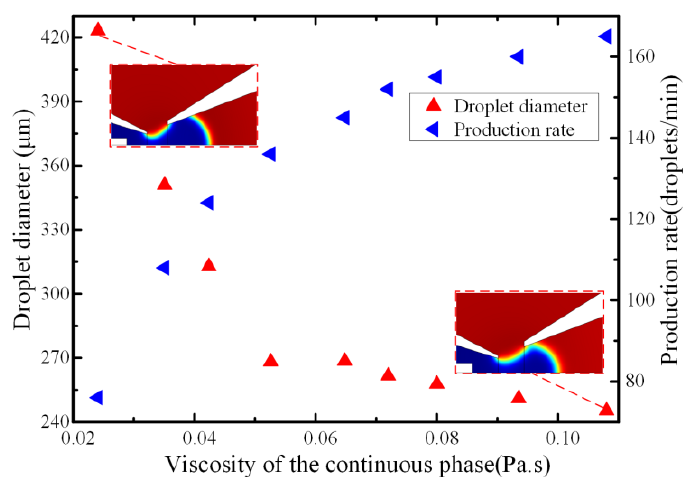
Figure7. Thee ff ectoftheviscosityofcontinuousphaseonthedropletdiameterandgenerationfrequency Figure 7. The effect of the viscosity of continuous phase on the droplet diameter and generation when the flowrate of continuous and dispersed phases were 100 µ L / min and 10 µ L / min, frequency when the flowrate of continuous and dispersed phases were 100 μL/min and 10 μL/min, respectively.